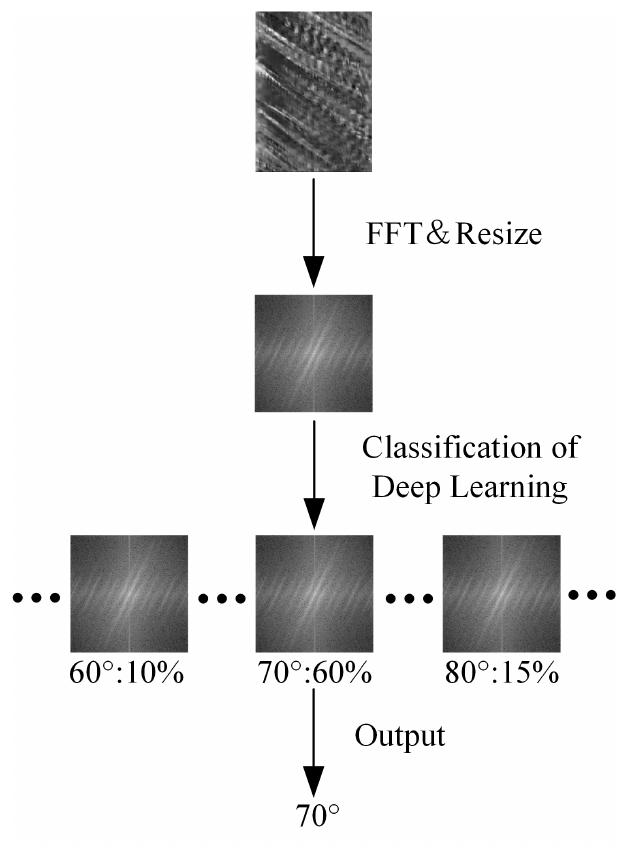
Figure 3. Process of MOT detection by deep